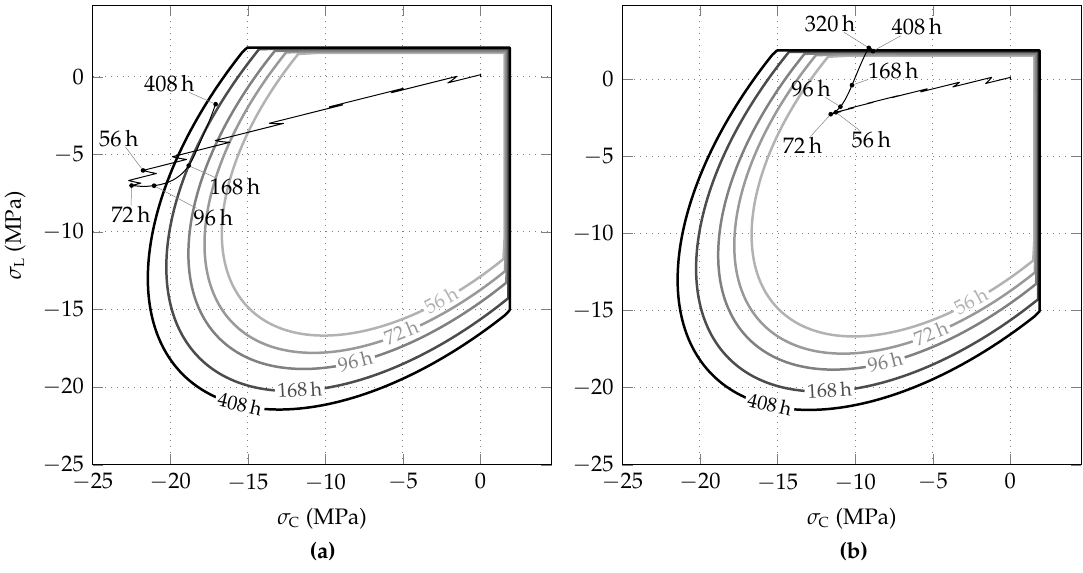
Figure 12. Evolution of biaxial strength envelopes of shotcrete and stress paths, predicted by the Meschke model for initial stress release ratios of ( a ) 85% and ( b )